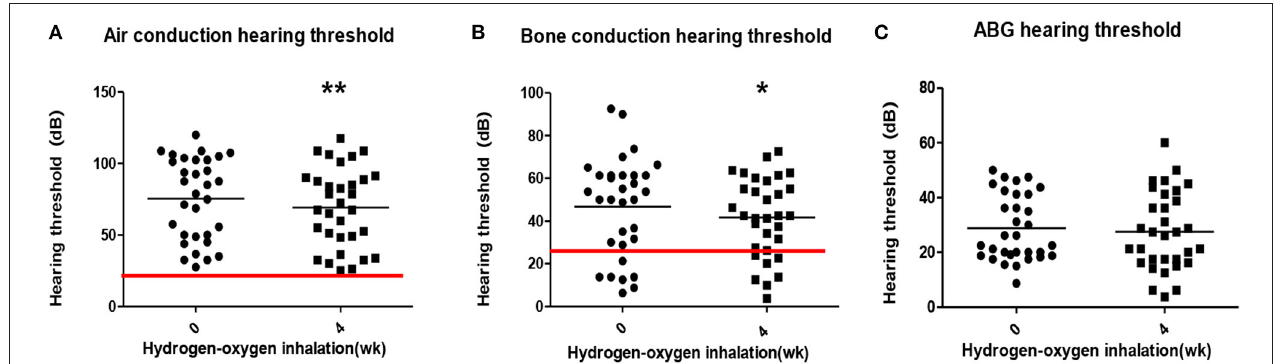
FIGURE 1 | Pure tone hearing threshold tests result before and after hydrogen-oxygen mixed gas inhalation on hearing loss patients with long-term survival after combined modality treatment of nasopharyngeal carcinoma. (A) Test results of the air conduction hearing threshold. (B) Test results of the bone conduction hearing threshold. (C) Test results of the air bone gap (ABG) hearing threshold. The parallel red long lines in the figure represent the normal range,the black short lines represent the average value at each time point. Data are analyzed by paired t test. * P < 0.05, ** P < 0.01.